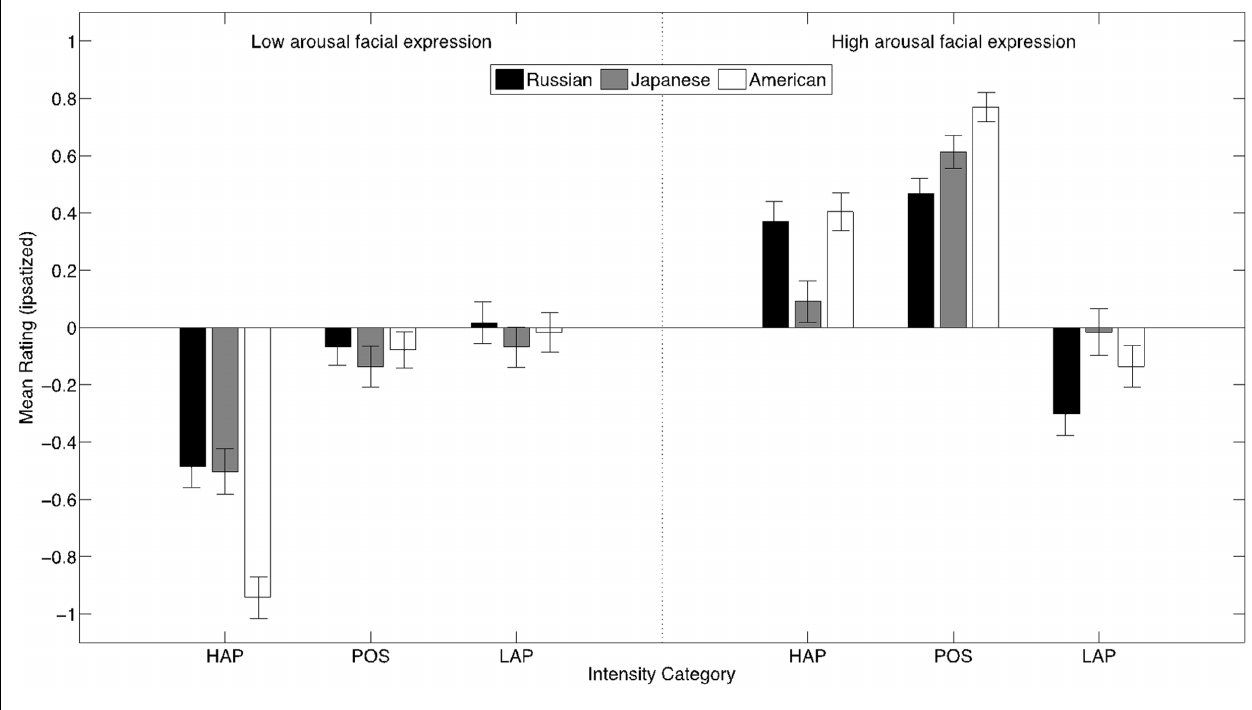
intensity categories (HAP, POS, LAP) for low and HA facial expressions. Significant cultural differences obtained from this additional analysis confirm those reported in the main paper and are listed in detail in TableA5